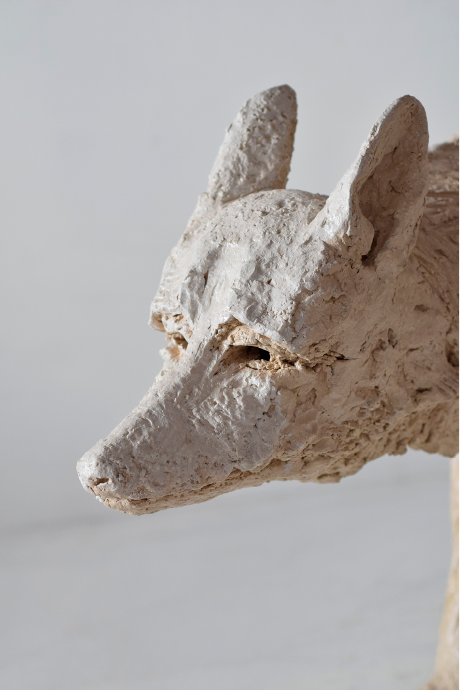
Figure 10. Vixen (2020), Alternator Studio. Ceramic, 48 × 60 × 25 cm.